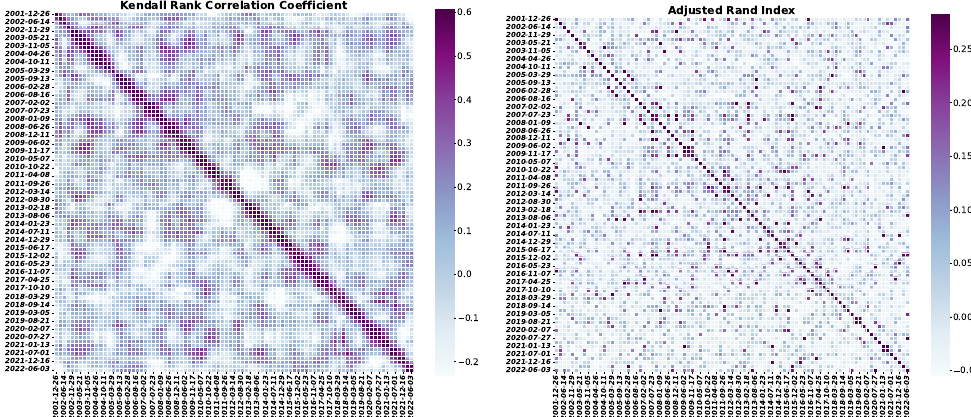
Figure 7. Short-term stability analysis of informational efficiency rankings and clusterings of 27 in- ternational markets moving with quarterly steps. ( Left ) Time evolution plot of the Kendall rank correlation coefficient (kendal- τ ) for all pairs of efficiency ranks at different time windows. ( Right ) Time evolution plot of the adjusted rank index (ARI) for all pairs of similar efficiency clusters at different time